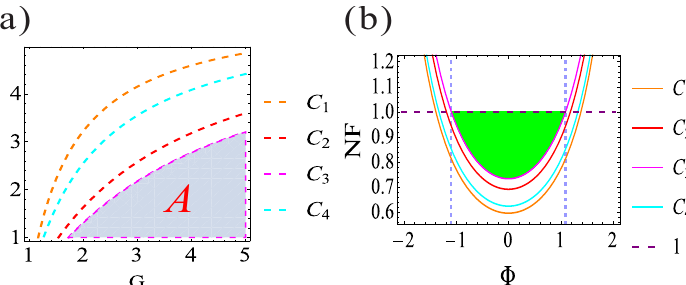
Figure 4. The dependence of Equation (9) on G and λ for the case of Φ = 0 in ( a ), and Φ for the case of G = 3 and λ = 1 in ( b ). The purple dashed line is 1, and the vertical dashed lines are Φ = ( − 1.1,1.1 )